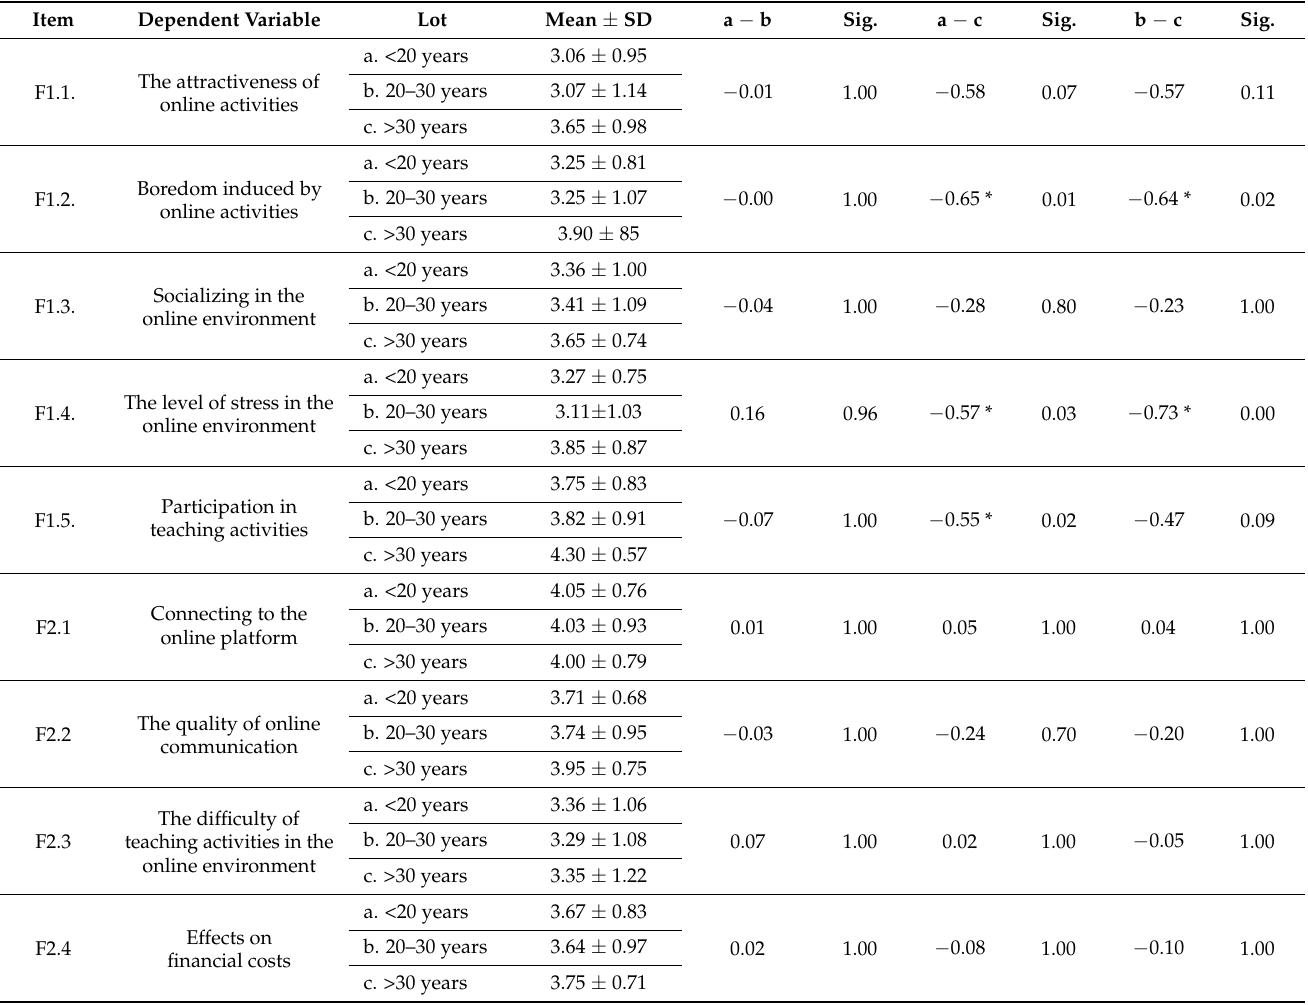
Table 4. Multiple comparison on the differences of the averages between the pairs by age